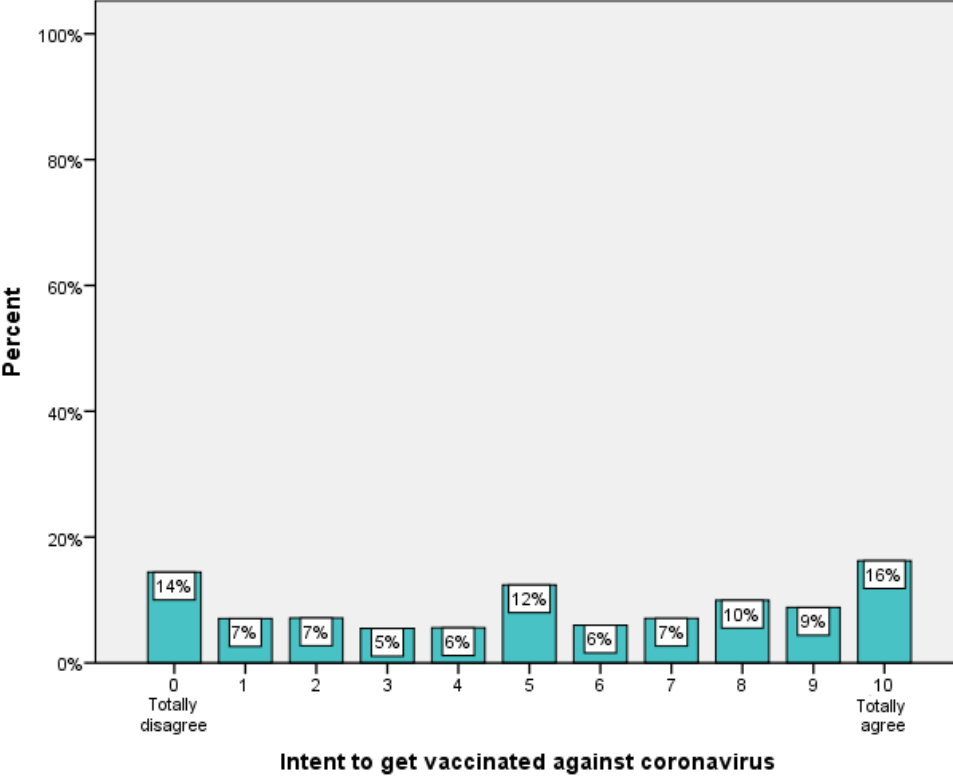
Figure 1. Students’ intention to get vaccinated against coronavirus.